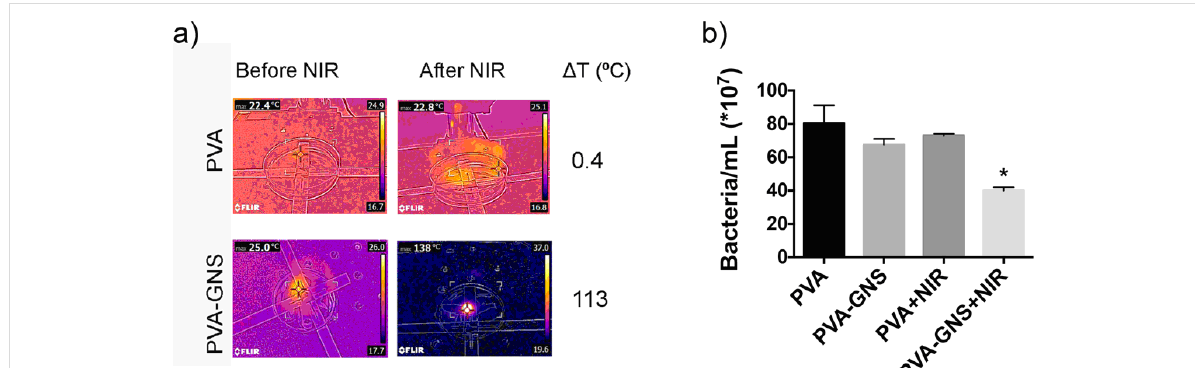
Figure 5: Workflow scheme of the antibacterial properties study.